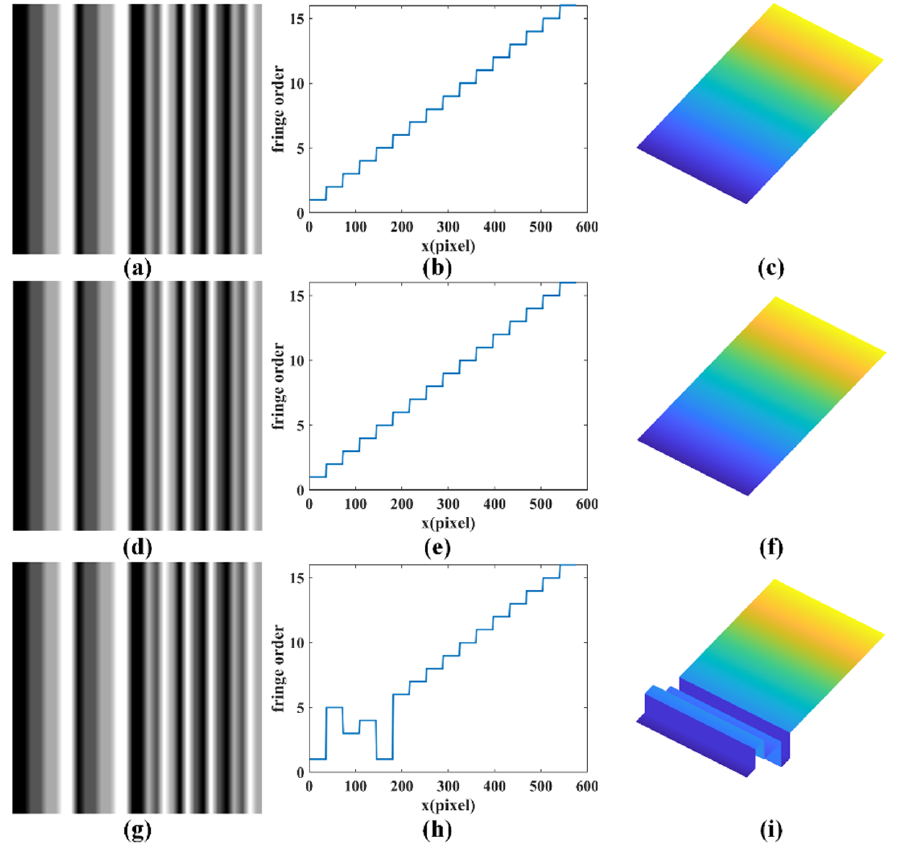
Figure 5. Blurred reference patterns and results of simulation with different standard deviation σ . ( a – c ) Blurred reference pattern, one section of fringe order and reconstruction of reference plane with σ = 5, respectively. ( d – f ) Blurred reference pattern, one section of fringe order and reconstruction of reference plane with σ = 10, respectively. ( g – i ) Blurred reference pattern, one section of fringe order and reconstruction of reference plane with σ = 15, respectively.